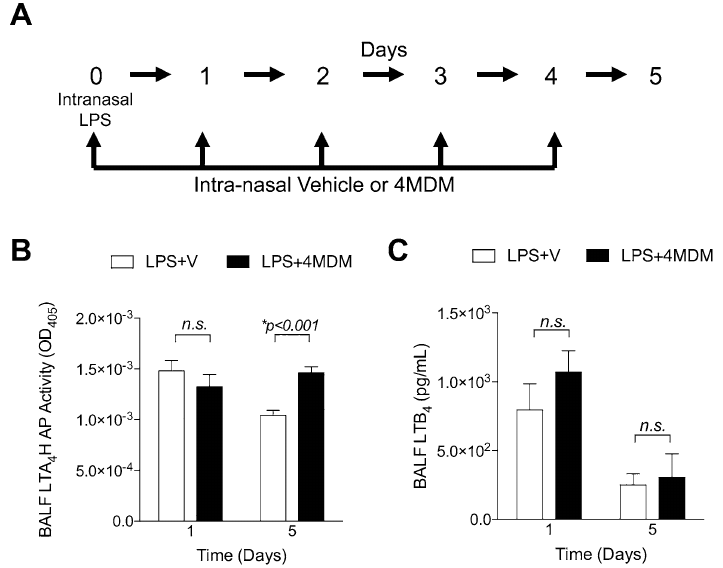
Figure 1. ( A ) Experimental design of the murine model of acute lung injury induced by intranasal lipopolysaccharide (LPS). ( B ) LTA 4 H aminopeptidase activity in the bronchoalveolar lavage fluid. ( C ) LTA 4 H epoxide hydrolase activity in the bronchoalveolar lavage fluid reflected by the levels of LTB 4 . Veh = cyclodextrin vehicle in phosphate-buffered saline. 4MDM = drug in the vehicle. *Significant p -values by Holm-Sidak comparison. n.s., not